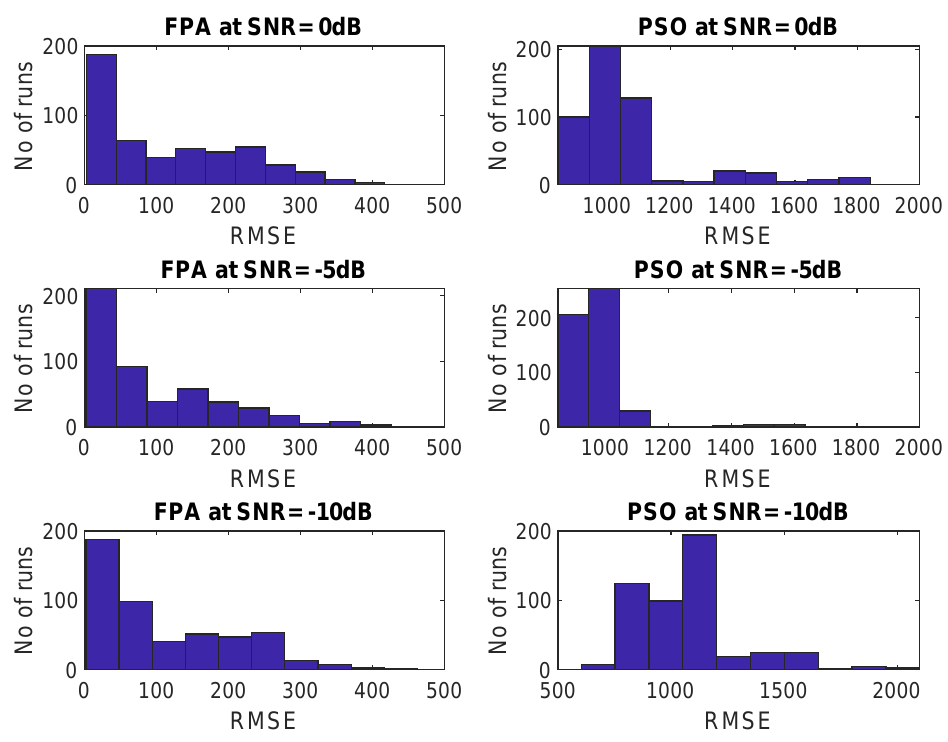
Figure 18. Histogram analysis of RMSE for eleven